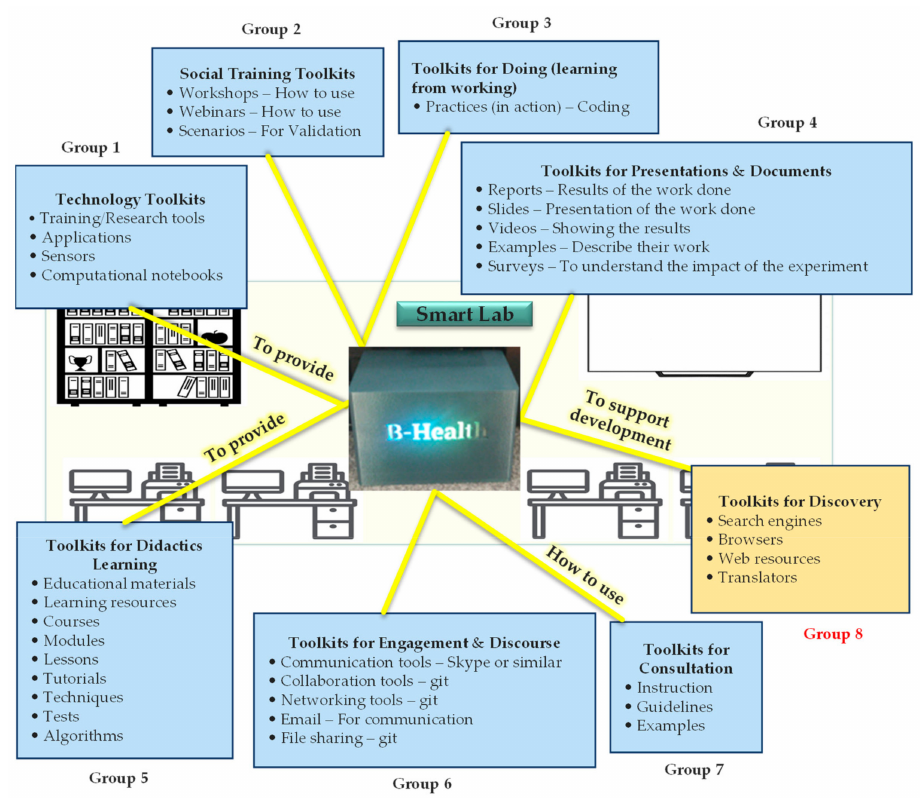
Figure 6. Package of training Toolkits provided by B-Health Box